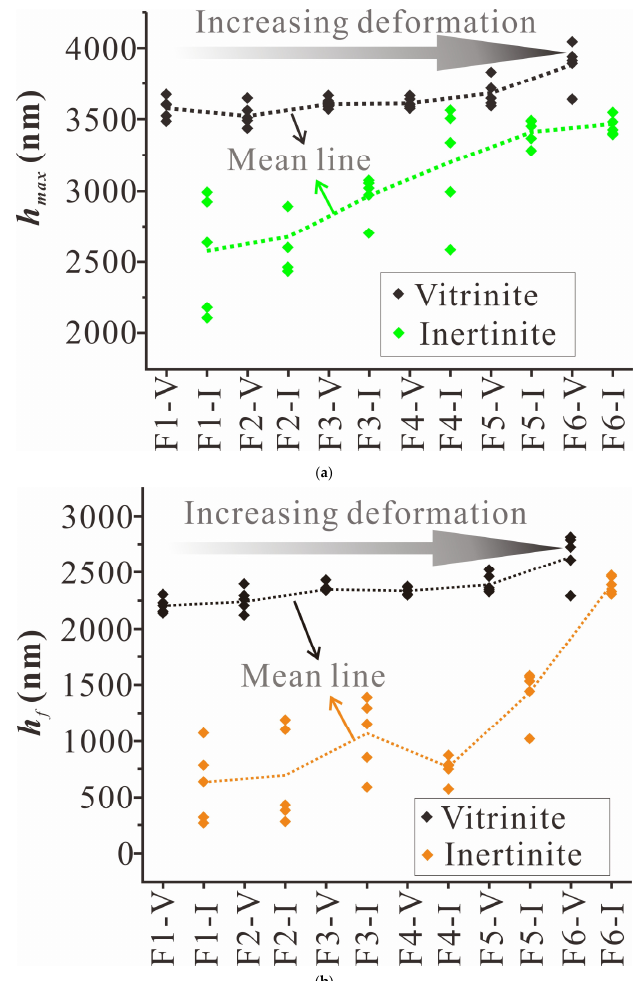
Figure 5. h max and h f of tectonically deformed coal samples. ( a ) h max of samples ( b ) h f of samples. h max is the maximum depth; h f is the distance between the deepest point of the sunken surface and the initial surface.